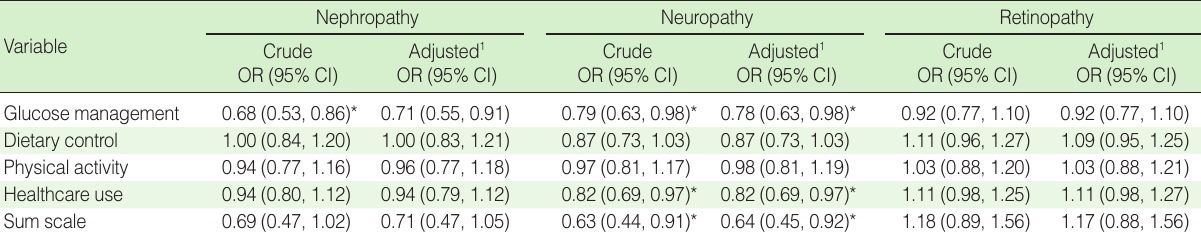
Table 4. Crude and adjusted associations between diabetes self-management and the microvascular complications of diabetes Variable Glucose management